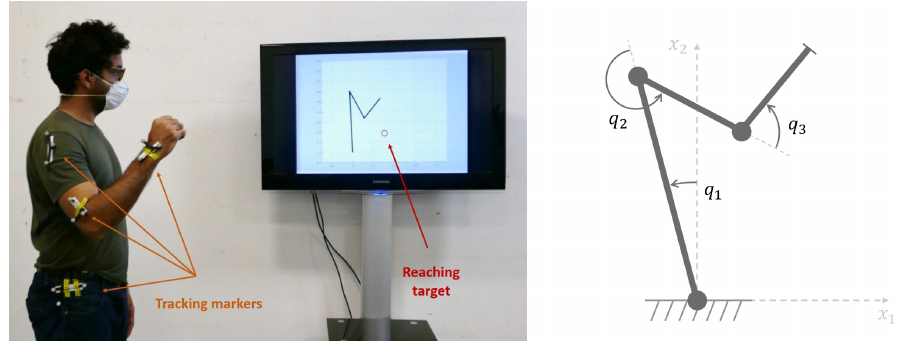
Fig 8. (Left) The second experimental setup where a human subject controls a virtual kinematic chain on the screen using respective bodily joints. (Right) A 3-link planar chain was used in this experiment. The first two joints ( q 1 and q 2 ) are directly controlled using the participant’ hip and shoulder, respectively. The virtual elbow ( q 3 ) is controlled differently depending on the experimental condition. This figure is borrowed from our previous work [83] where we provide further technical details on the experimental setup and the control modes for the virtual